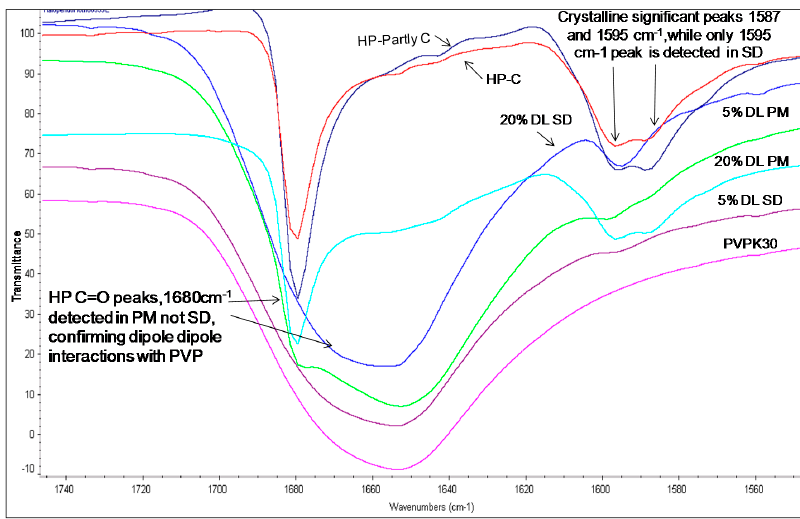
Figure 5. FTIR spectra of HP-PVPK30 solid dispersion (SD) and physical mixture (PM) (1680 cm − 1 ) showing -C=O stretching region at 1680 cm − 1 in crystalline, (C) partly crystalline and physical mixture, which shifts in SD.